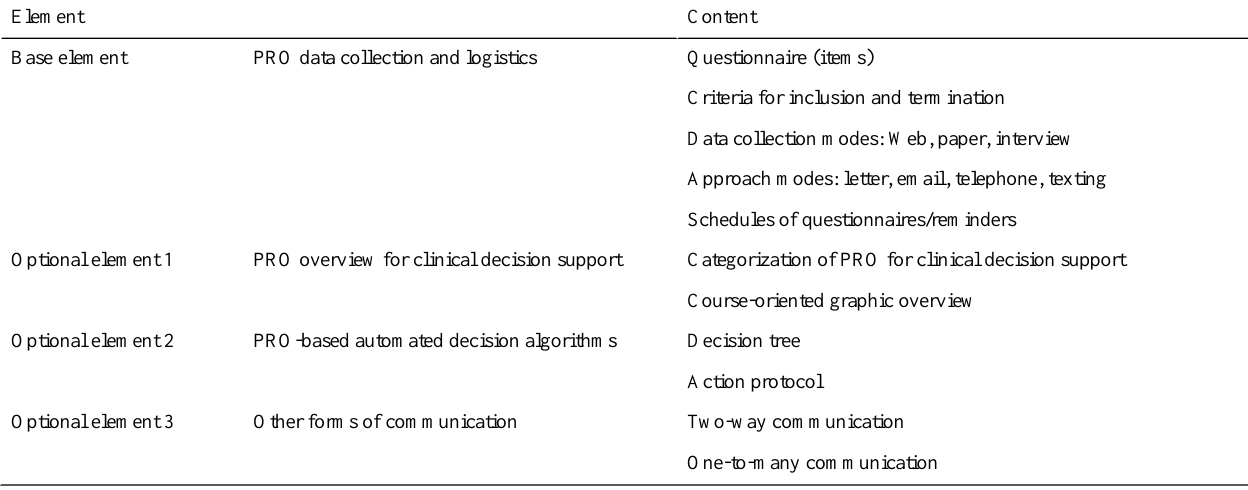
Table 1. Elements of clinical application of patient-reported outcomes (PRO).